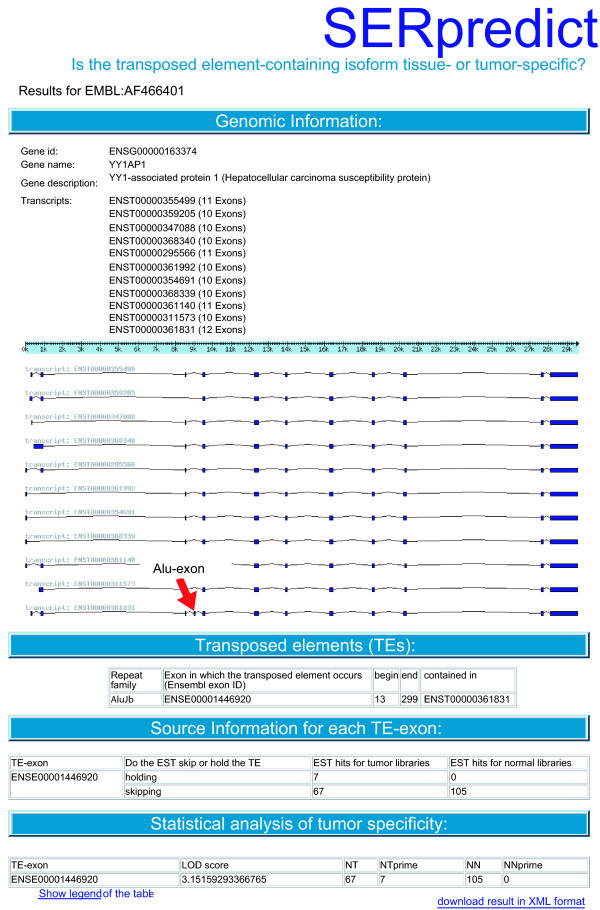
Example output of SERpredict. The output of SERpredict for [EMBL:AF466401] is presented. One of the isoforms shows a tumor-specific exon which was generated through the exonization of an Alu element.